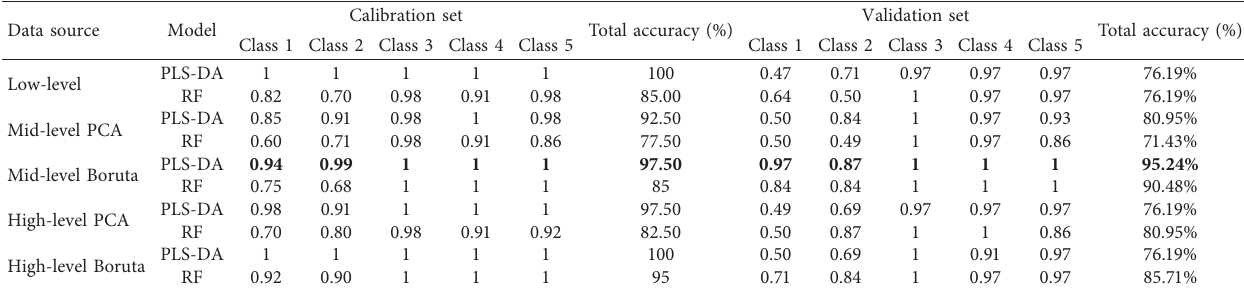
Table 2: The classification efficiency and total accuracy rates of different data fusion strategies in wild